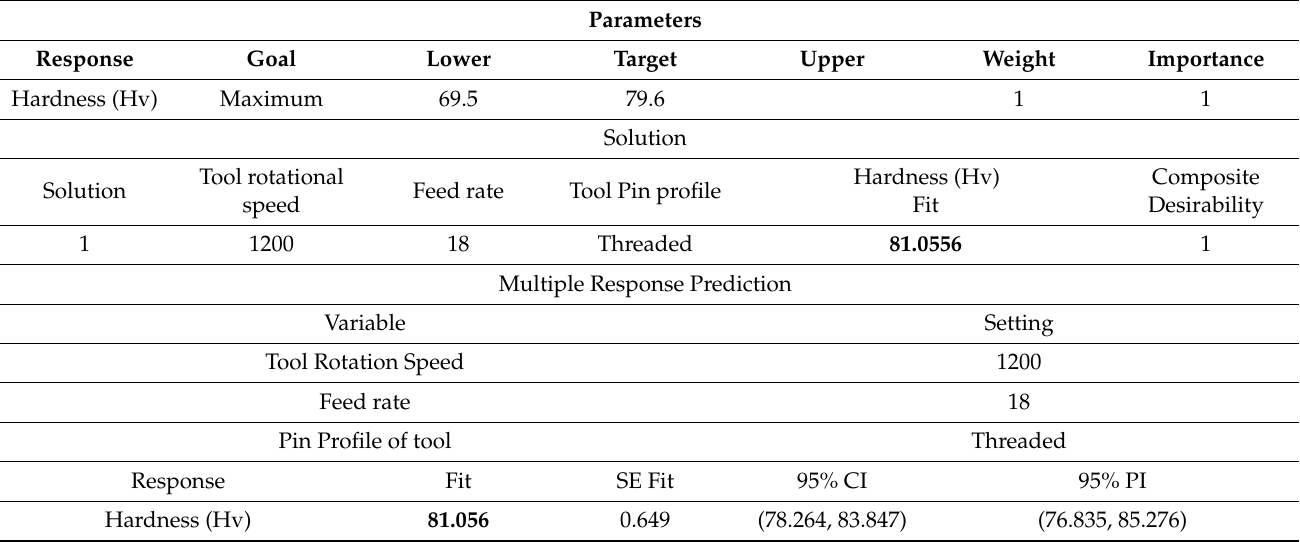
Table 8. Response optimization for